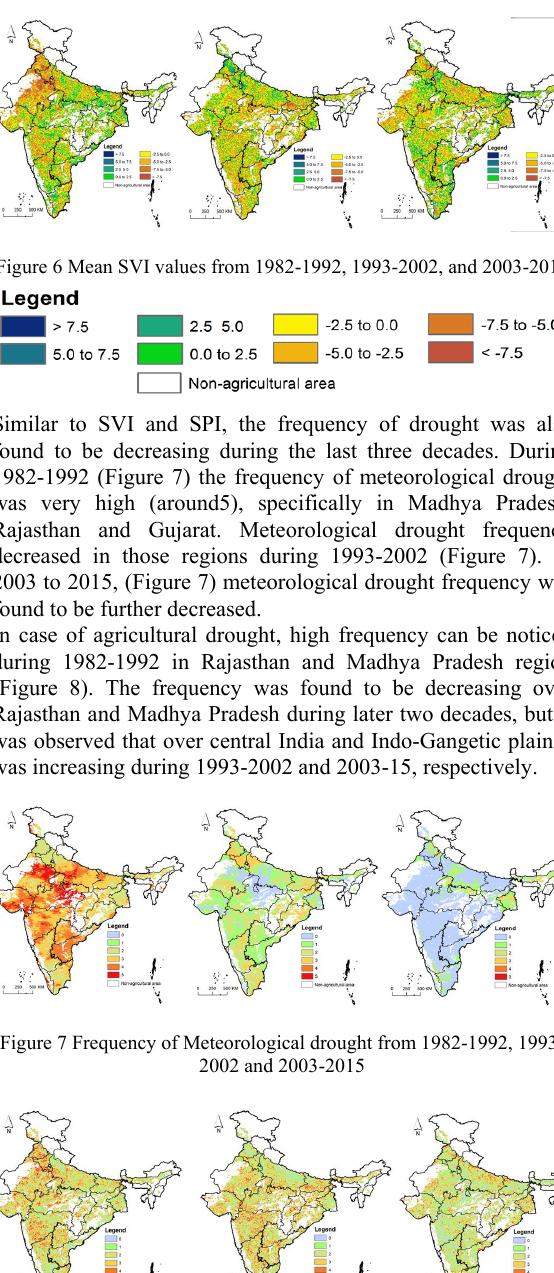
Figure 5 Mean SPI values from 1982-1992, 1993-2002, 2003-2015